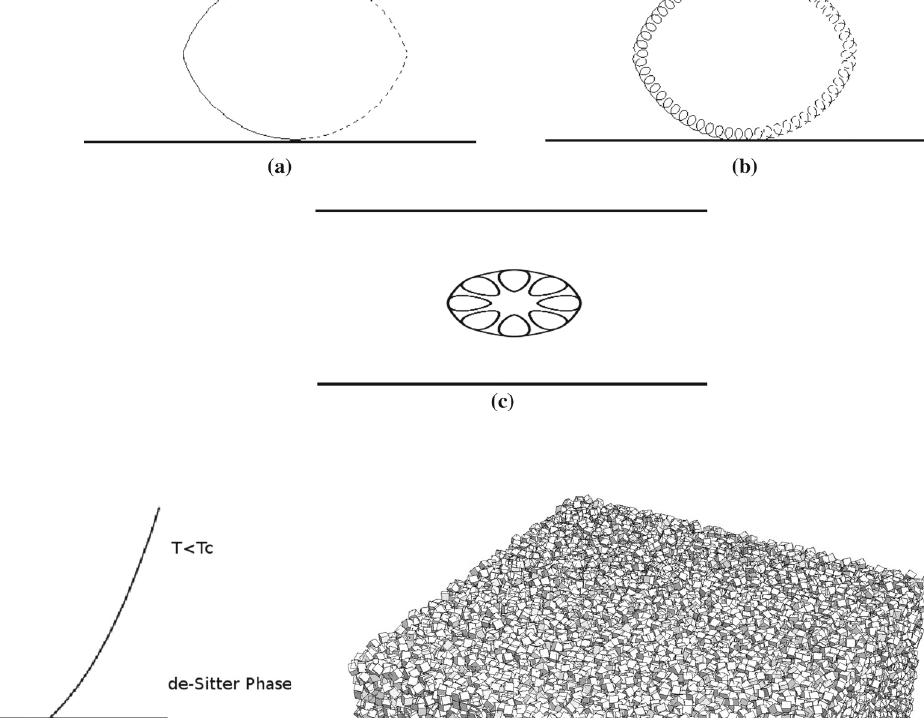
Fig. 5 Virtual particles polarize